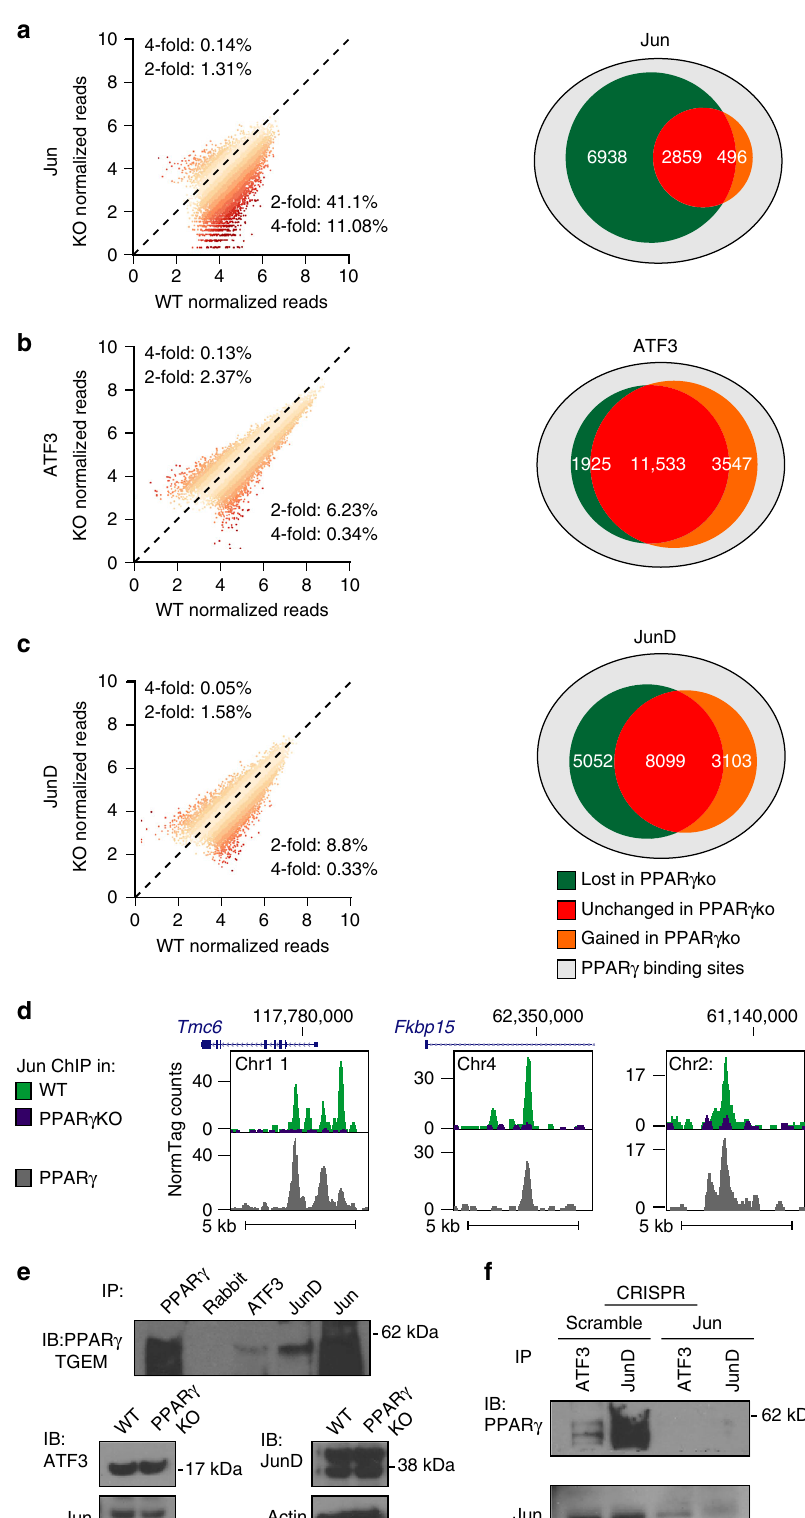
Fig. 7 The Jun-speci fi c DNA binding program is preferentially altered in PPAR γ knockout macrophages. a – c Changes in binding strength all binding sites in wild type macrophages in PPAR γ -KO macrophages (left) and Venn diagrams summarizing the change in binding at binding sites that overlap with PPAR γ (right) for Jun ( a ), ATF3 ( b ), and JunD ( c ). d Representative browser shots of Jun in WT and PPAR γ -KO thioglycollate elicited macrophages (TGEMs) and PPAR γ in WT TGEMs. e Western blot analysis of co-immunoprecipitation experiments between AP-1 monomers ATF3, Jun and JunD and PPAR γ in TGEMs. f Western blot analysis of co-immunoprecipitation experiments between AP-1 monomers ATF3 and JunD and PPAR γ in scramble immortalized bone marrow-derived macrophage (iBMDM) or CRISPR-mediated Jun knockout